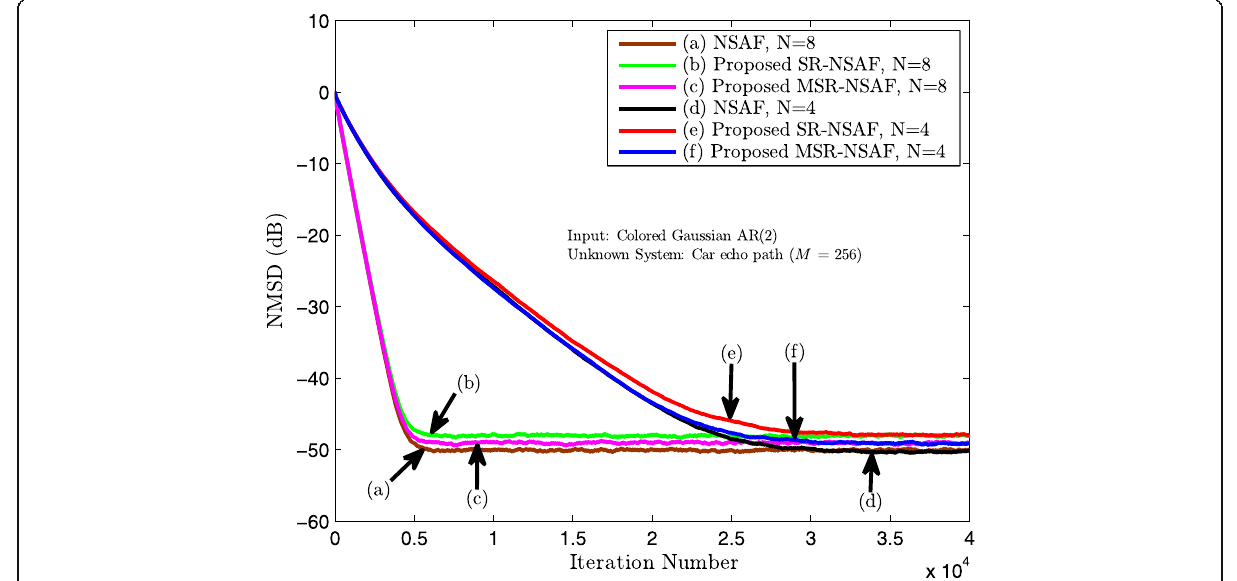
Fig. 5 NMSD learning curves of the NSAF ( N = 4 and 8), SR-NSAF, and MSR-NSAF ( μ =